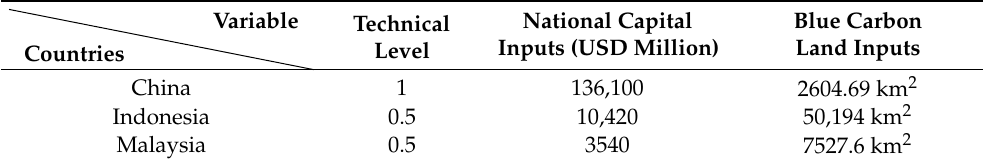
Table A1. Variables of countries along the